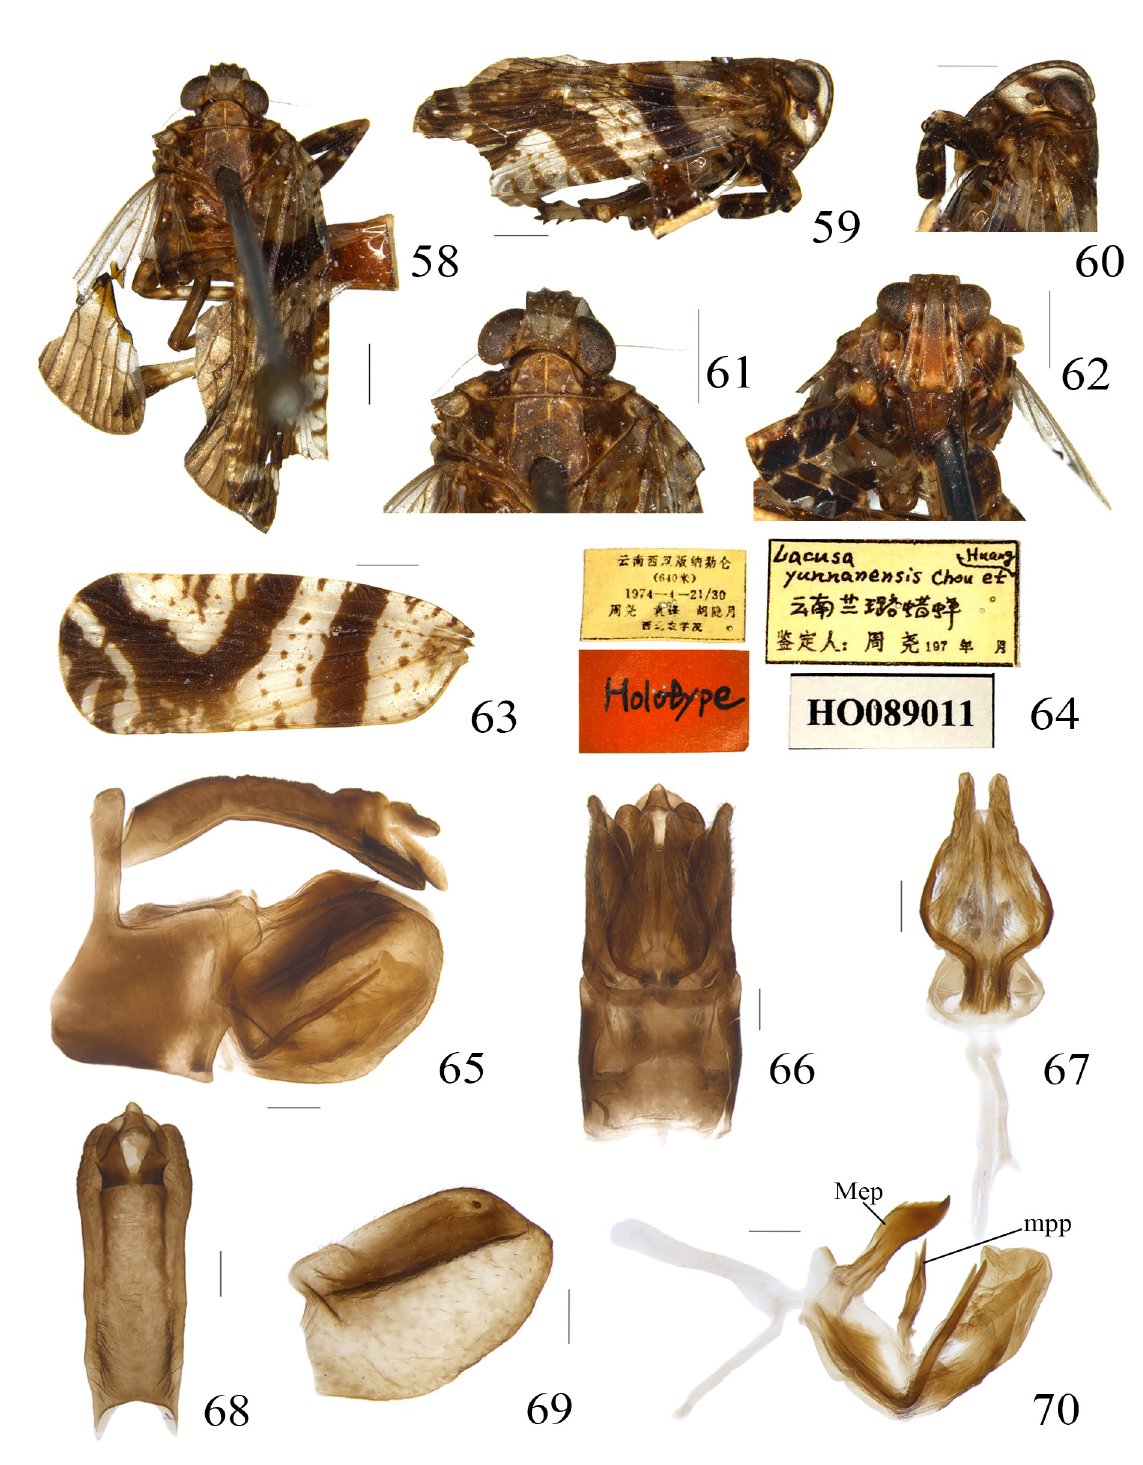
Figs 58–70. Lacusa yunnanensis Chou & Huang, 1985 stat. rev., holotype, ♂. 58 . Habitus, dorsal view. 59 . Habitus, lateral view. 60 . Head, lateral view. 61 . Head and thorax, dorsal view. 62 . Frontal view. 63 . Tegmina. 64 . Labels. 65 . Male terminalia, lateral view. 66 . Male terminalia, ventral view. 67 . Phallic complex, ventral view. 68 . Anal tube, dorsal view. 69 . Gonostylus, lateral view. 70 . Phallic complex and tectiform structure, lateral view. Scale bars: 58–63 = 1 mm; 65–70 = 0.2